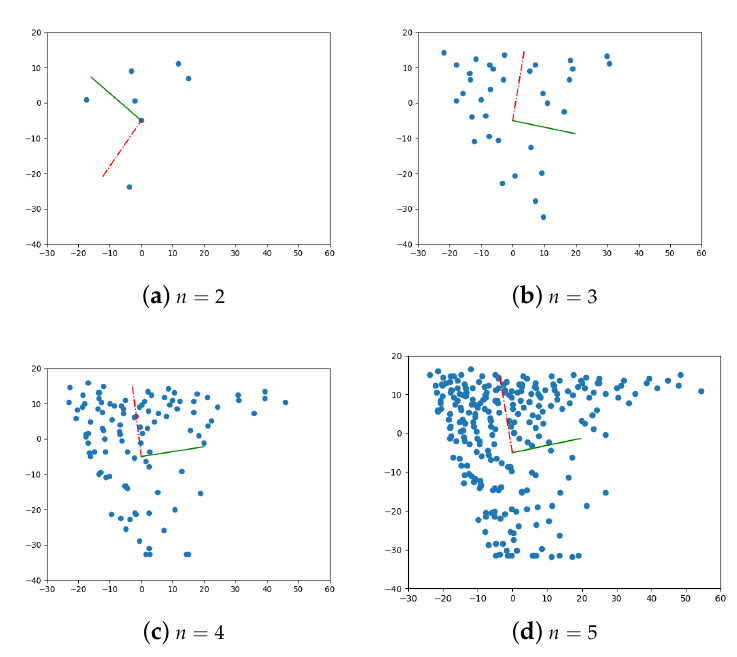
Figure 7. Global view of objective space for each n and their